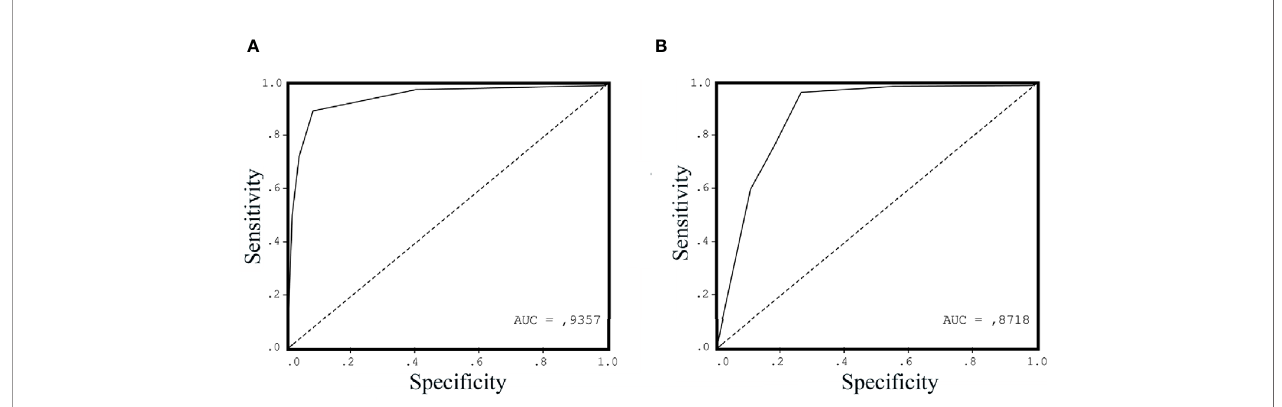
FIGURE 3 | Receiver operating characteristic curve (ROC) for urinary Integrin alpha V (ITGAV) (A) and serum prostate-speci fi c antigen (PSA) (B) levels in patients with prostate cancer (PCa) vs. control group subjects. The area under the curve (AUC) is shown for each ROC analysis, making 0.9357 for urinary ITGAV and 0.8718 for